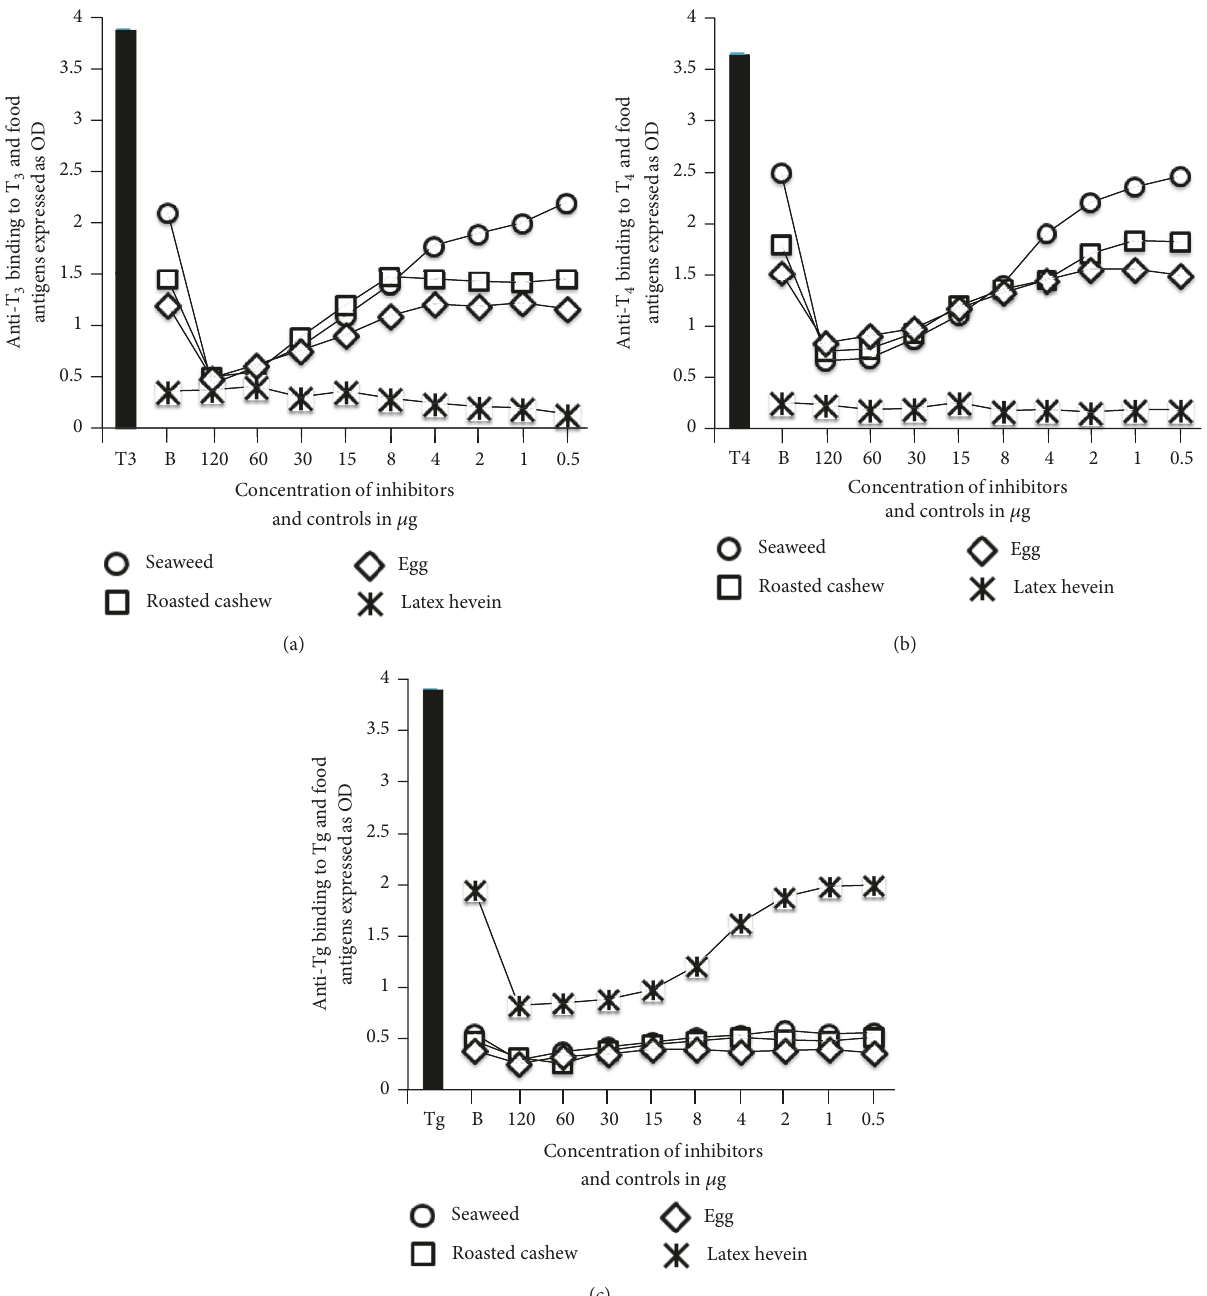
Figure 3: Inhibition of T3 (a), T4 (b), and Tg (c) antibodies with different concentrations of food